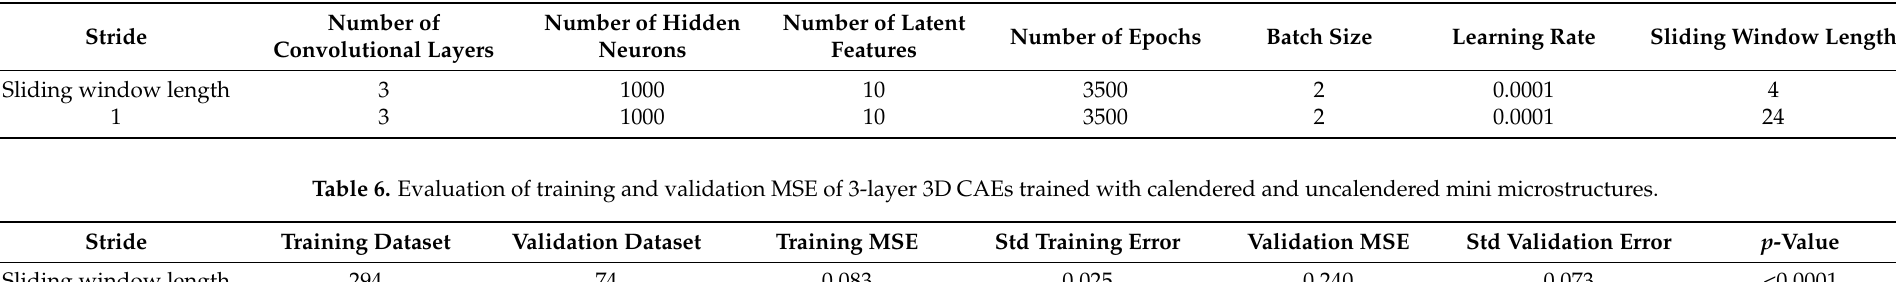
Table 5. Optimal hyper-parameters configuration of 3D CAEs using calendered and uncalendered microstructures.